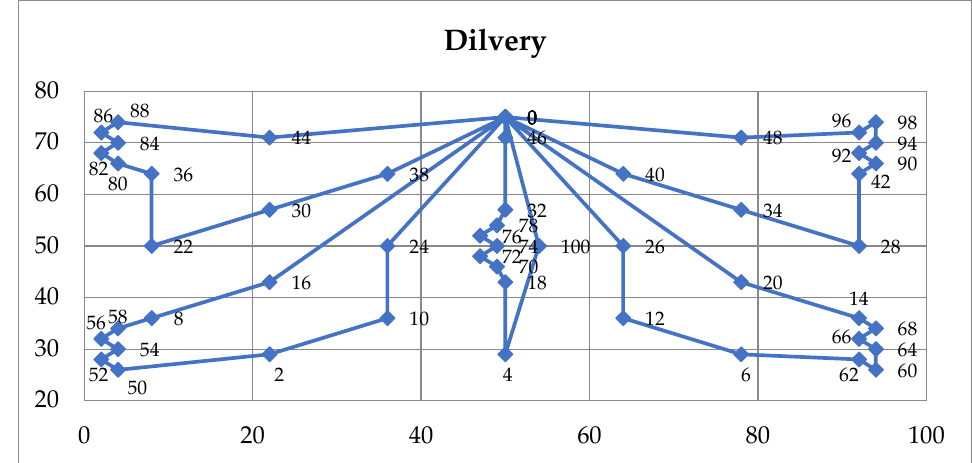
Figure A2. Optimized delivery routes from sAIS for instance 53P1.